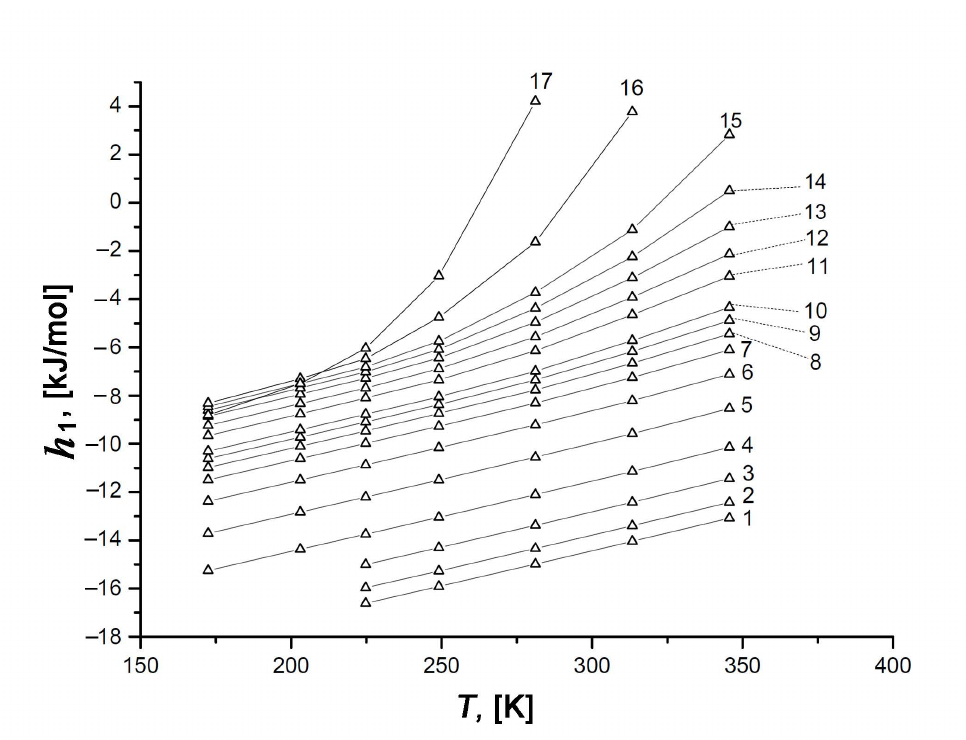
Figure 13. Temperature dependence of the differential molar enthalpy, h 1 , of the Xe/SiC-AC adsorp- tion systems at the values of adsorption a , mmol/g: 1—0.1 (1), 0.3 (2), 0.6 (3), 1.0 (4), 1.5 (5), 2.0 (6), 2.5 (7), 3.0 (8), 3.5 (9), 4.0 (10), 5.0 (11), 5.5 (12), 6.0 (13), 6.5 (14), 7.0 (15), 8.0 (16), and 9.0 (17). Symbols are the results of calculations by Equation (13), lines are the spline